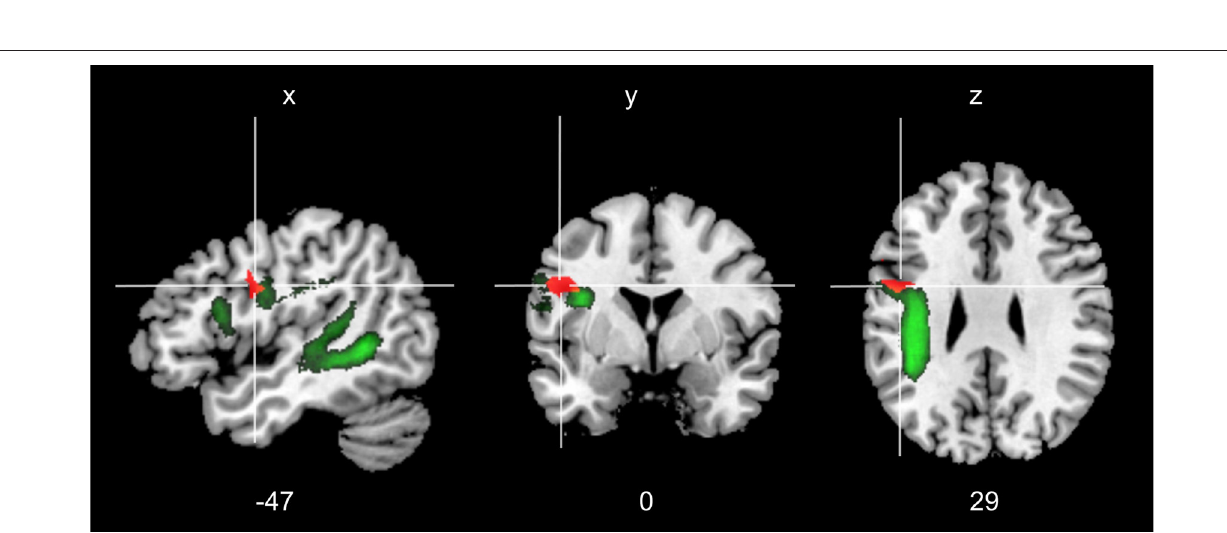
FIGURE 5 | Overlap maps of the brain lesions in the patient group. The z-position of each axial slice in the Talairach stereotaxic space is presented at the bottom of the figure.